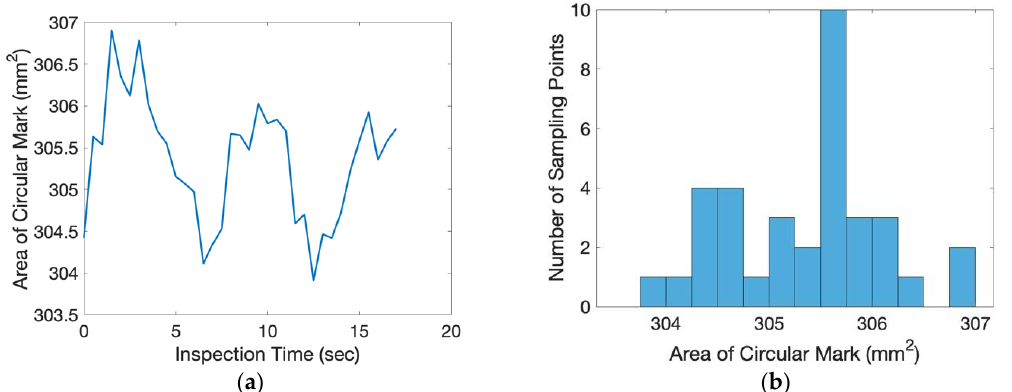
Figure 13. The measured area of the circular mark during the inspection process: ( a ) analysis with respect to time, ( b ) histogram of analysis.